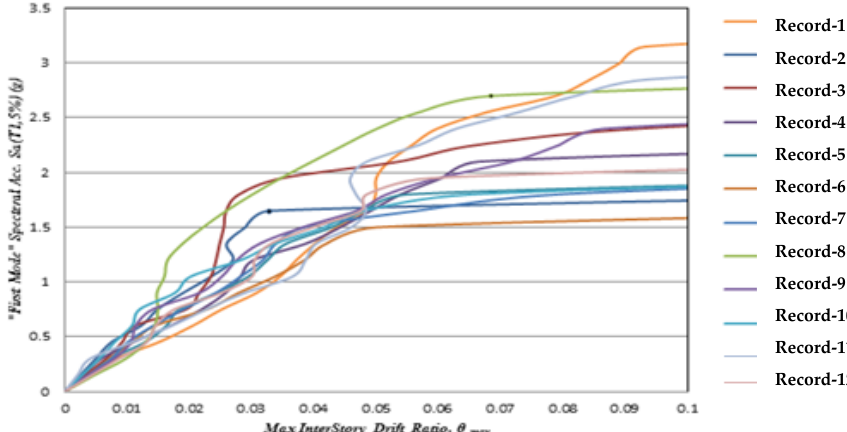
Figure 17. IDA curves obtained for a 10-story building with simple connections.